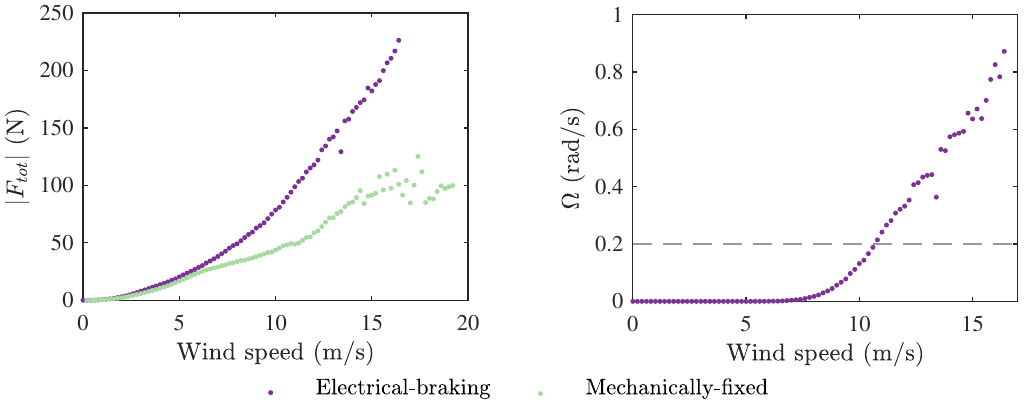
Figure 10. Left : Bucket sorted total force with respect to wind speed. Note that the dominating wind direction during the mechanically-fixed case was from a direction resulting in a low force on the blade. Right : The rotational speed as a function of wind speed during electrical braking. Note that the rotational speed sensor lower limit is 0.2rad/s, and data below this limit are a result of the